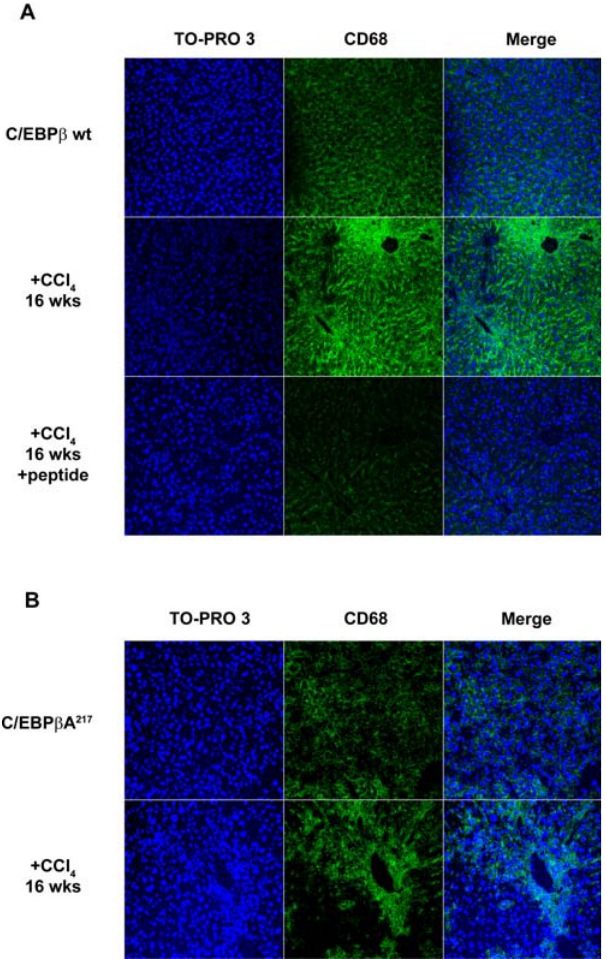
Figure 3. Mice expressing the RSK-inhibitory C/EBP b -Ala217 trans- gene are resistant to hepatotoxin-induced liver inflammation. Mice were treated with CCl 4 or control mineral oil for 16 weeks as described in Materials and Methods. A. Activated monocytes/macrophages, identified by confocal microscopy for CD-68 (green), were increased in livers of C/EBP b + / + [wt] mice treated with CCl 4 for 16 weeks (middle panels). Treatment of these animals after week 8 with the RSK-inhibitory peptide while continuing the exposure to the hepatotoxin, as described in Material and methods, blocked the monocytes/macrophage inflam- matory reaction at week 16 (lower panels). Nuclei are identified with TO-PRO-3 (blue). Only background staining was observed when omitting the first antibody. Microscopy shown is representative of six animals in each group. B. Activated monocytes/macrophages, were not increased in livers of C/EBP b -Ala217 mice as much as in the livers of C/ EBP b + / + [wt] mice after treatment with CCl 4 for 16 weeks (lower panel). Microscopy shown is representative of six animals in each group. proliferate, and become the main contributors of ECM [5] [6]. Because this step is required for the development of liver fibrosis and cirrhosis [7–9], we analyzed the activation and proliferation of HSC in the livers of mice chronically exposed to the hepatotoxin. As expected, chronic CCl 4 administration to C/EBP b + / + (wt) mice, induced marked activation of HSC, as indicated by the positive immunofluorescence for a -SMA within the scar tissue [5] [6] (Figure 4A), and proliferation of HSC, as indicated by the presence of proliferating cell nuclear antigen (PCNA; DNA poly- merase d auxiliary protein), an S-phase marker [28] (Figure 4B). By contrast, C/EBP b -Ala217 mice were refractory to the